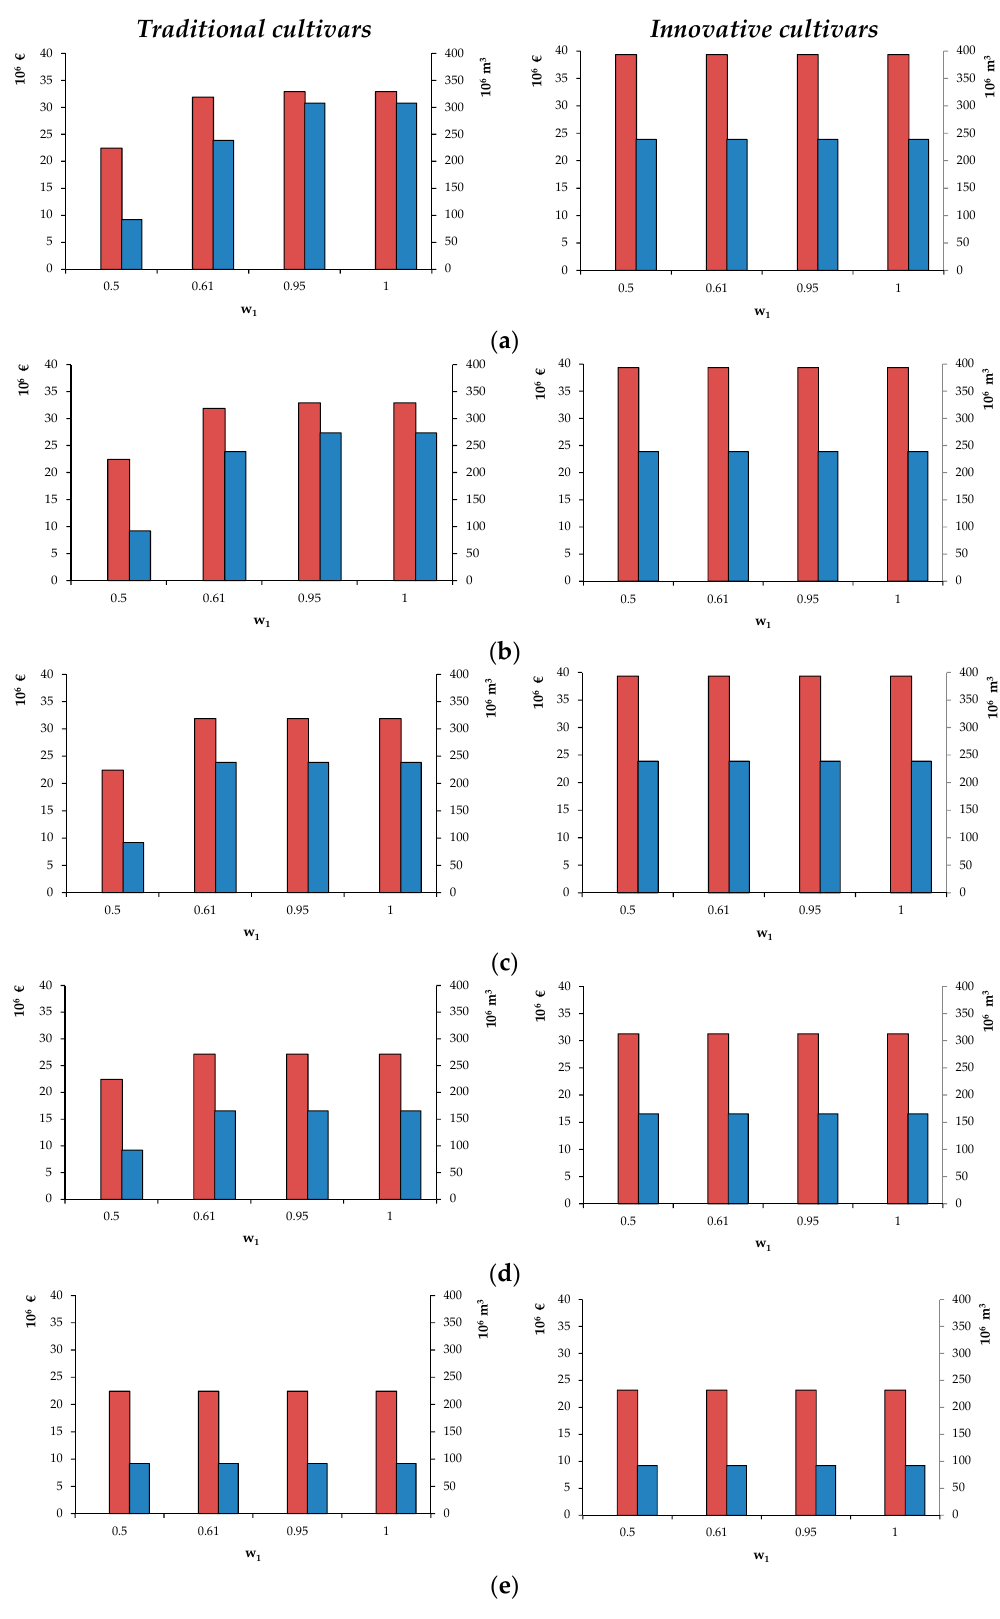
Figure 8. Gross margins (Mio. EUR, red series) and irrigation water amounts (Mio. m 3 , blue series) in the study area, under different water availability levels: ( a ) 2.19 L/s ∙ ha − 1 ; ( b ) 1.95 L/s ∙ ha − 1 ; ( c ) 1.70 L/s ∙ ha − 1 ; ( d ) 1.18 L/s ∙ ha − 1 ; ( e ) 0.66 L/s ∙ ha − 1 . Each scenario shows results of both prioritization weights and rice varieties cultivated.